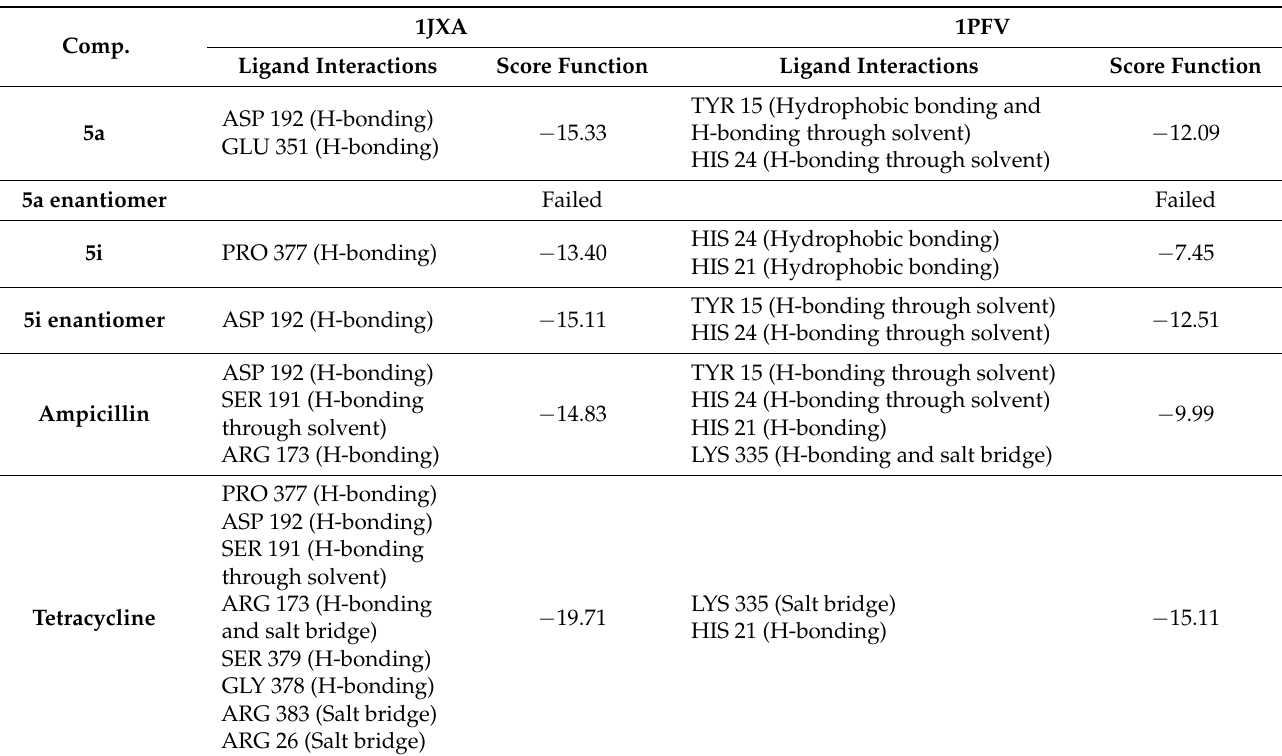
Table 7. Scoring function of docking poses and the interactions of the docked compounds 5a , 5i, 5i enantiomer, Ampicillin and Tetracycline with amino acid residues on glucosamine 6-phosphate